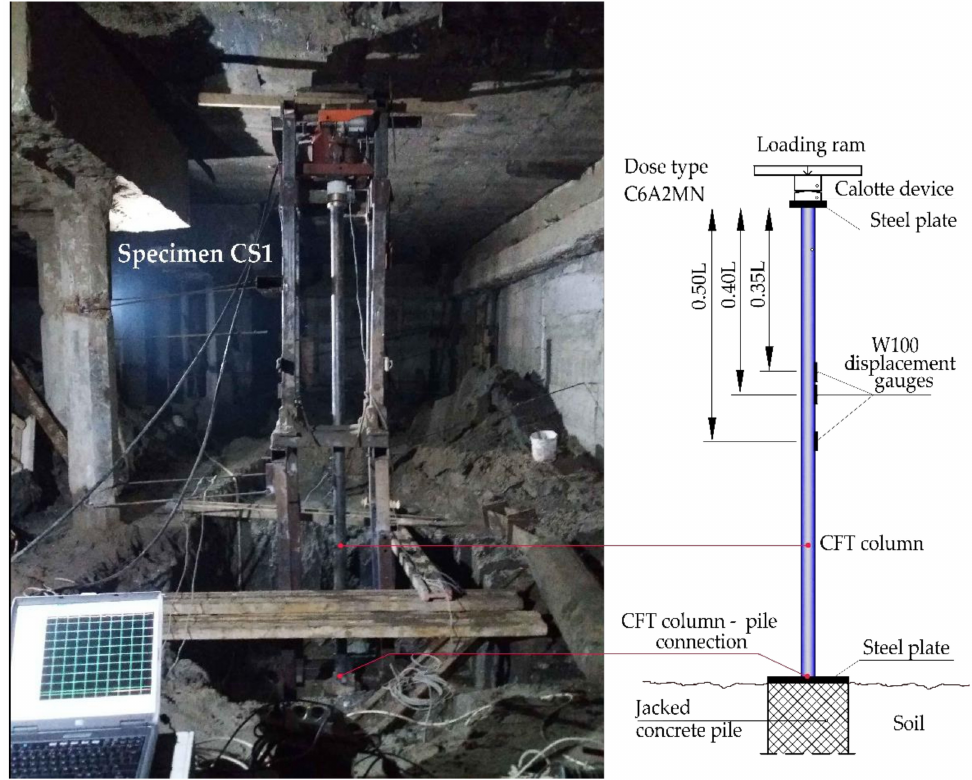
Figure 3. General test setup and testing of the specimen CS1.